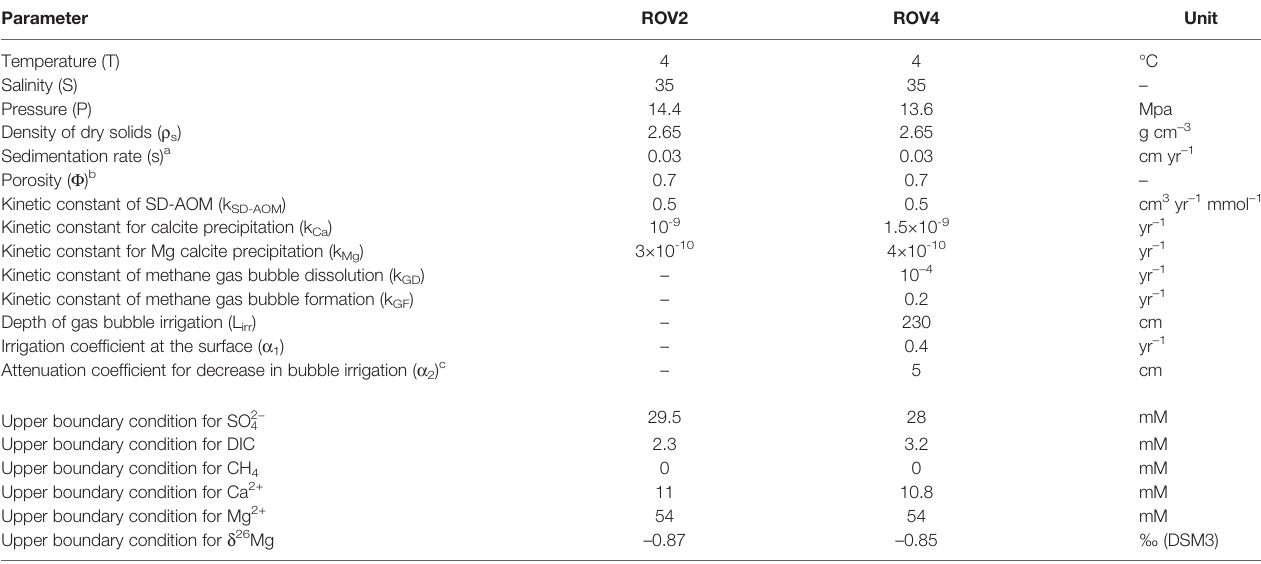
TABLE 1 | Parameters used in the model to assess Mg isotope fractionation.